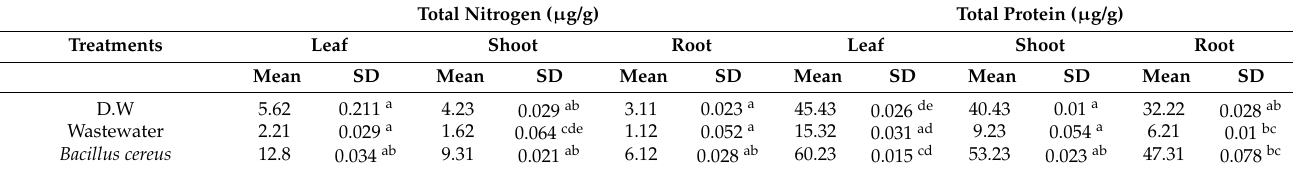
Table 3. The total nitrogen-protein contents in the leaf-shoot-root of rice plants that were grown under synergistic treatment of seeds that were primed with bacteria strains ( Bacillus cereus and Lysinibacillus macroides ) and grown in ZnO NPs (5 and 10 mg/L) alone or in combination with HMs-contaminated water. Control (distilled water), B.C + 5 mg/L ( Bacillus cereus + 5 mg/L ZnO NPs) and L.M + 5 mg/L ( Lysinibacillus macroides + 5 mg/L ZnO NPs), B.C + 10 mg/L ( Bacillus cereus + 10 mg/L ZnO NPs) and L.M + 10 mg/L ( Lysinibacillus macroides + 10 mg/L ZnO NPs). Values are the mean ( ± ) standard deviation of three replicates ( n = 3) followed by different alphabetic letters showing statistical significance at 5% probability level (ANOVA and Duncan’s multiple range